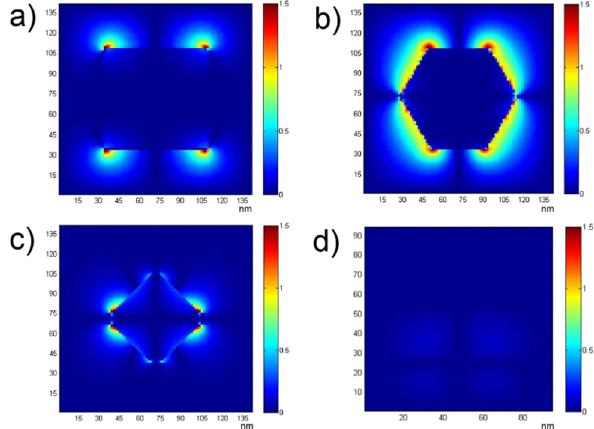
Figure 11: FDTD simulation analysis of time - averaged and normal - ised transverse electric fi eld distribution with di ff erent polyhedral AuNPs: ( a ) cube, ( b ) RD, ( c ) ECTO, and ( d ) triangle plate. [ 126 ] ; Copyright ( 2015 ) American Chemical